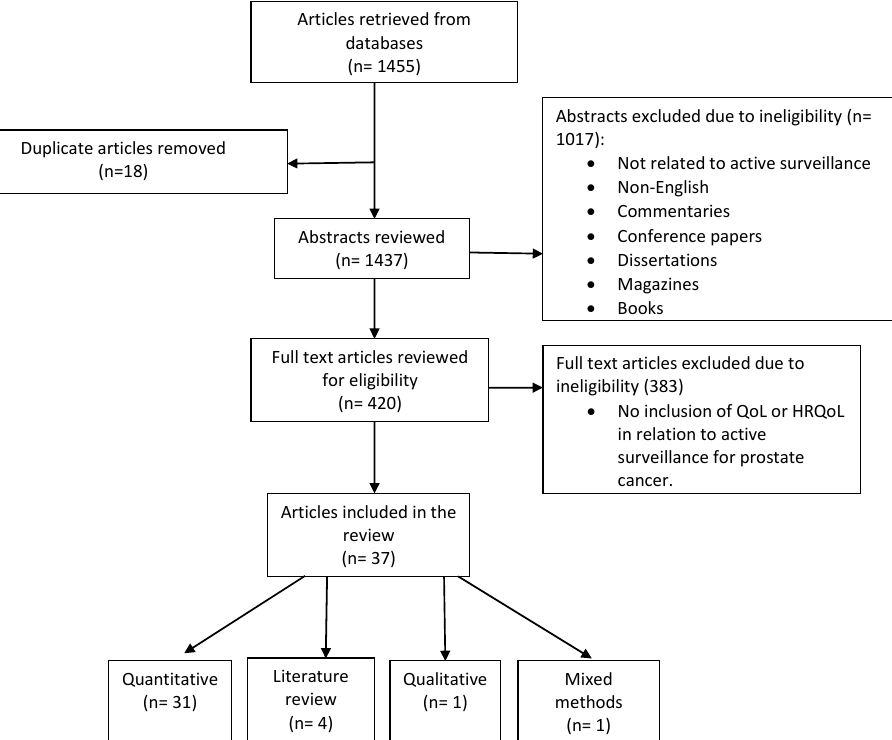
Figure 1. Data flow chart of the article selection process.